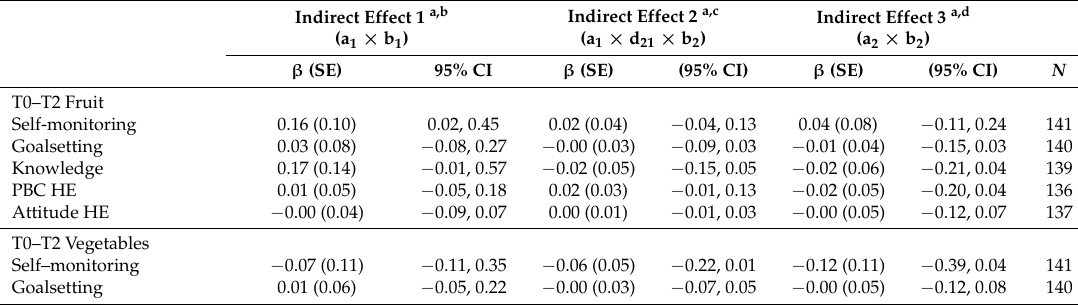
Table 4. Mediation of the intervention’s effect on diet quality and physical